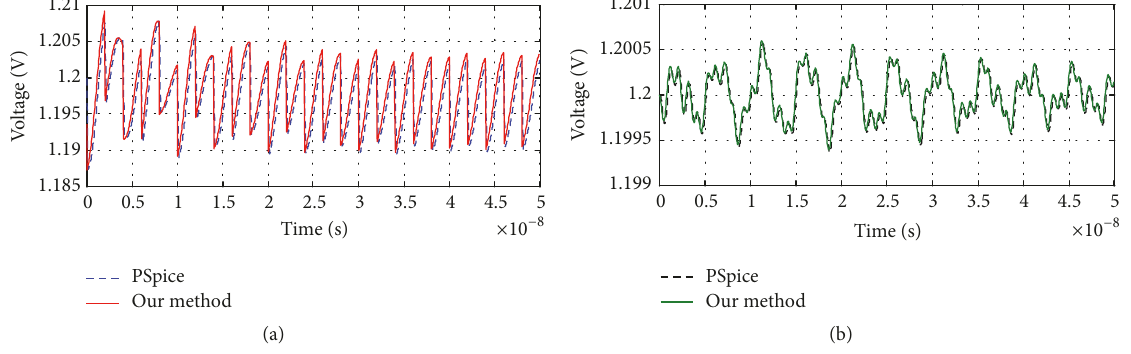
Figure 12: SSN waveform of the PDN near the second core; 𝐶